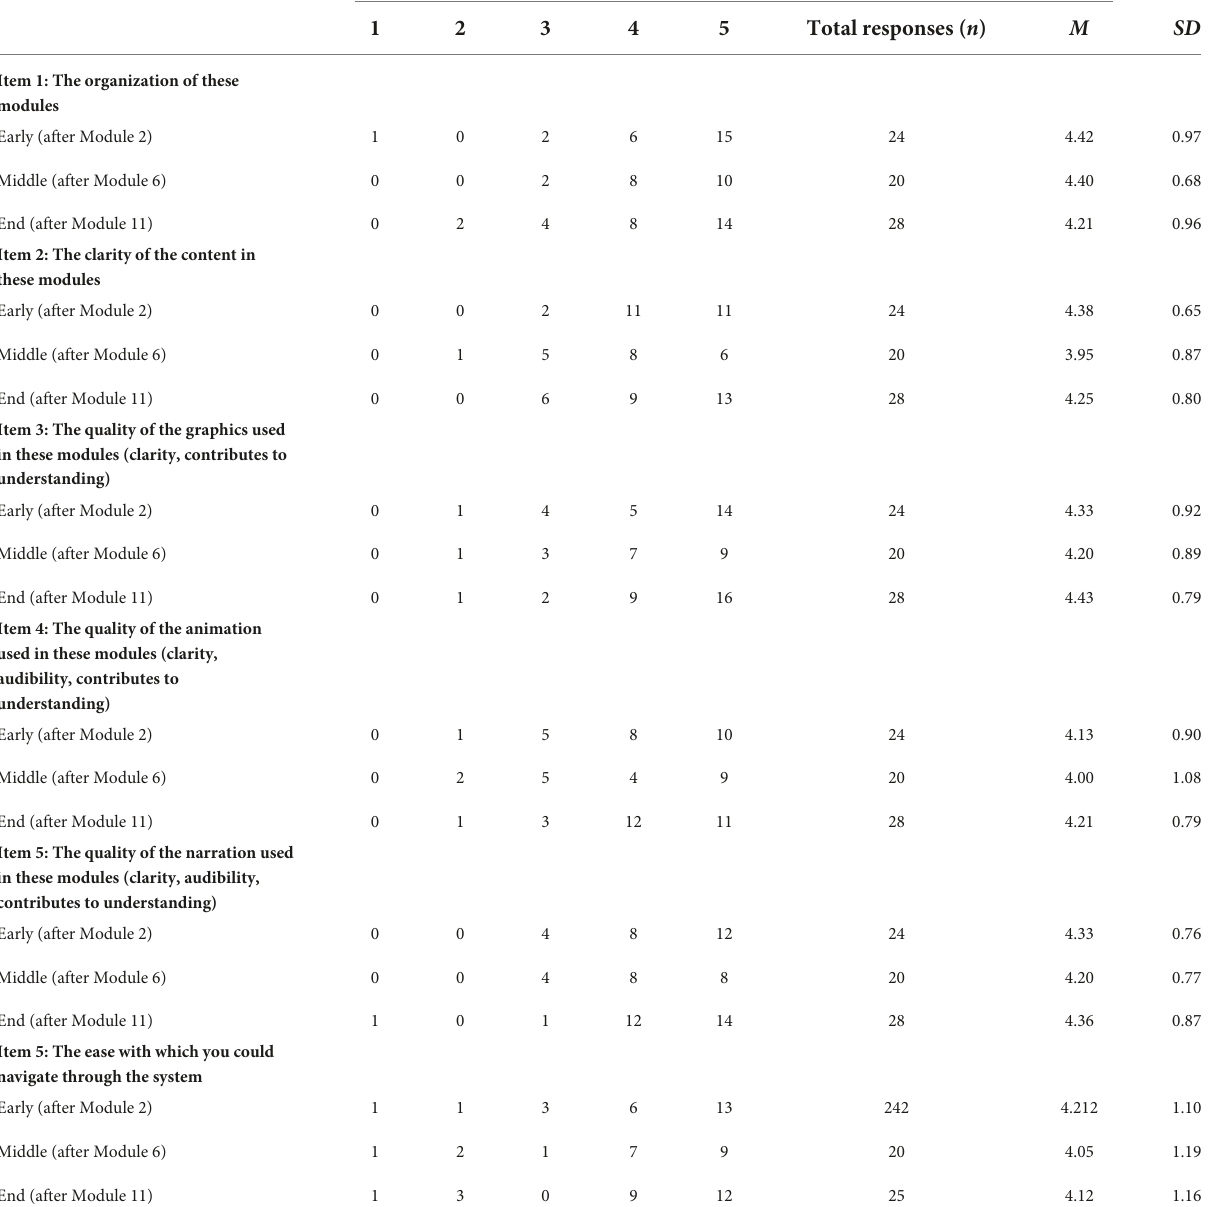
TABLE 10 Teacher ratings of modules: Organization, navigation, and quality. Item and point in